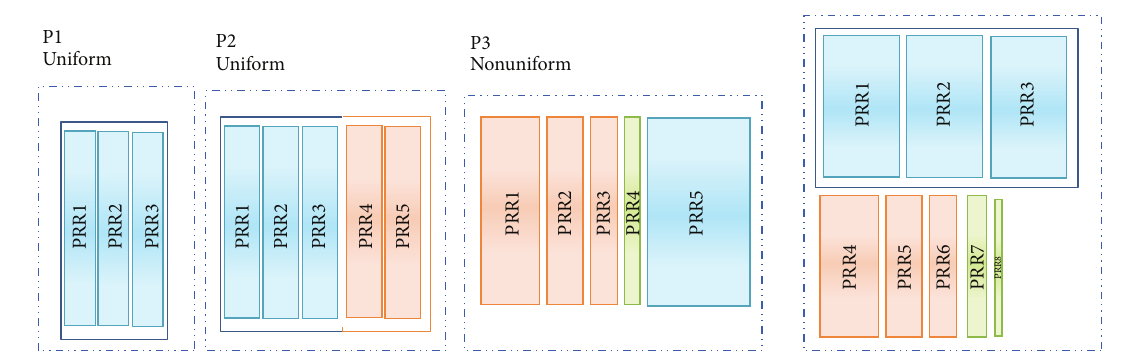
Figure 12: Platforms with different floorplans.